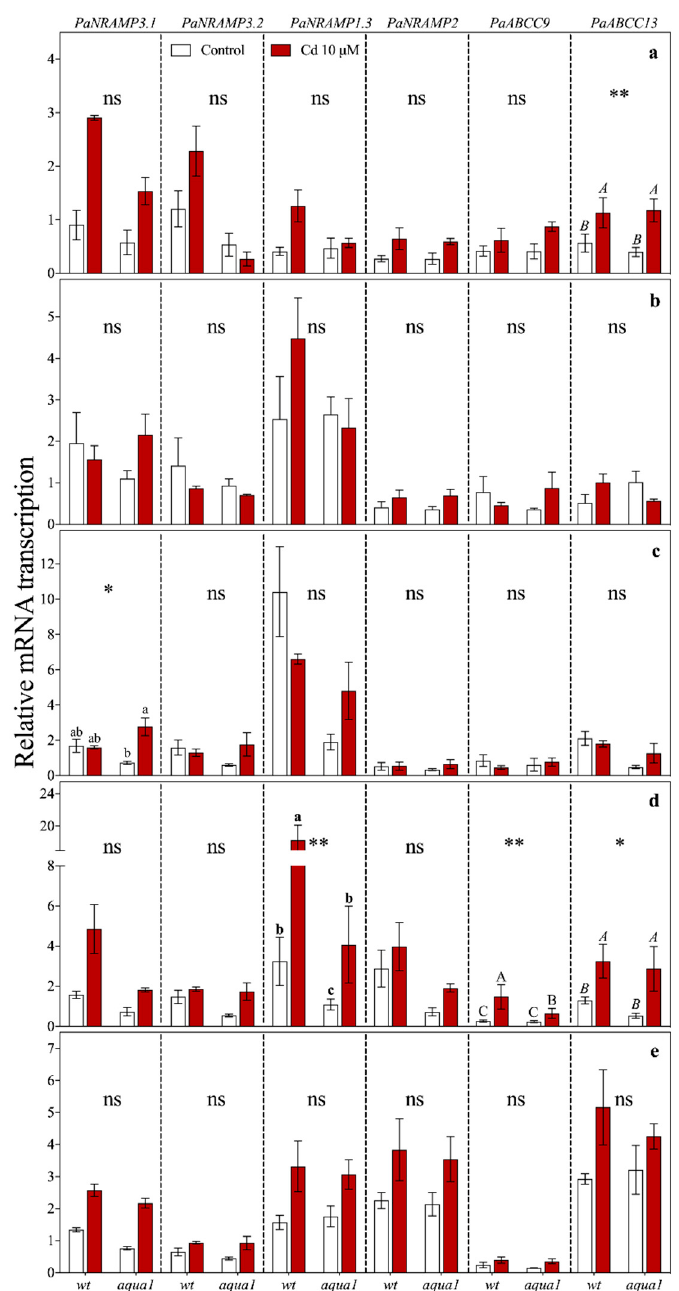
Figure 7. Gene relative transcript abundance in apical ( a ), medial ( b ), and basal ( c ) leaves, stem ( d ), and root ( e ) at 60 d of treatment. Values represent the mean of three biological replicates ± SE. Data were analysed with two-way ANOVA; p -values correspond to the interaction between Cd and Line are reported in the figure (* = 0.01 < p < 0.05, ** = 0.001 < p < 0.01, ns = not significant). When the interaction was significant, different letters indicate significant differences among treatments at each sampling time and organ. Cd and Line p -values are reported in Table S3.